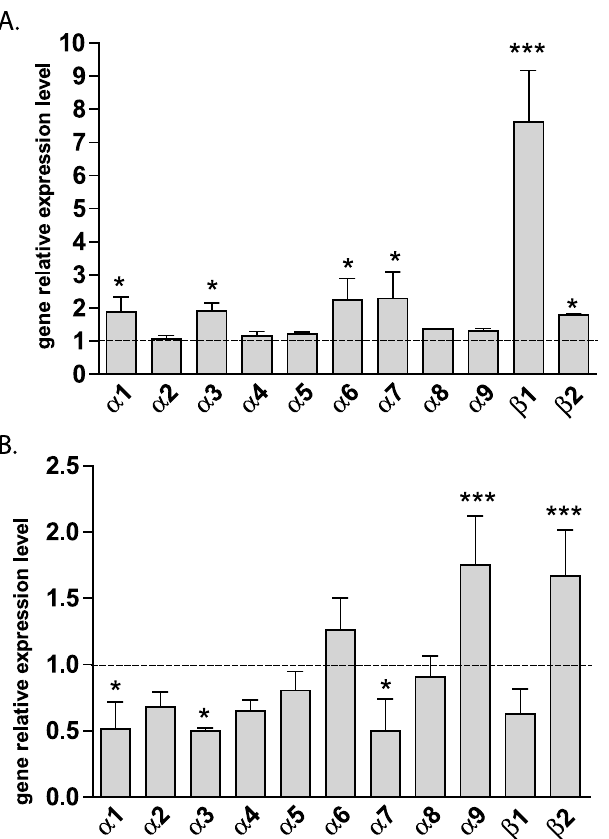
Fig 7. Expression levels of nAChR mRNA subunits in honeybee brains. A . relative expression level of nAChR subunits in bees with learning ability impairment after sulfoxaflor exposure. Experiments were based on honeybees exposed to sulfoxaflor 12h before conditioning that were unable to learn at the end of olfactory conditioning. B . relative expression level of nAChR subunits in bees with memory retrieval impairment after sulfoxaflor exposure. Experiments were based on honeybee exposed to sulfoxaflor 23 h 30 after conditioning (i.e. 30 min before the 24 h retrieval test) that did not show PER during the retention test. For all experiments, results are expressed as a percentage of the control. For each gene, the expression levels in the control group corresponds to 100% and is represented by a dotted line. Each qPCR experiment was performed in triplicate and results are the mean of four independent experiments. Relative expression ratios were normalized using two reference genes, gapdh and rp49 . Error bars represent the SEM. Statistical analysis (t-test, α = 0.05) was carried out using Graphpad Prism 5 software and results statistically different from control are marked with an